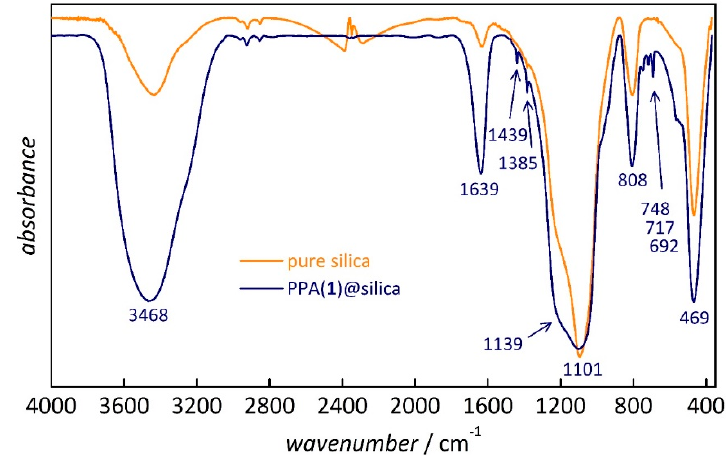
Figure 1. Fourier ‐ transform infrared (FT ‐ IR) spectra of pure silica (monolith) and of the Fourier-transform infrared (FT-IR) spectra of pure silica (monolith) and of the phenylphosphonic acid (PPA) ( 1 )-functionalized phenylphosphonic acid (PPA) ( 1 ) ‐ functionalized silica.